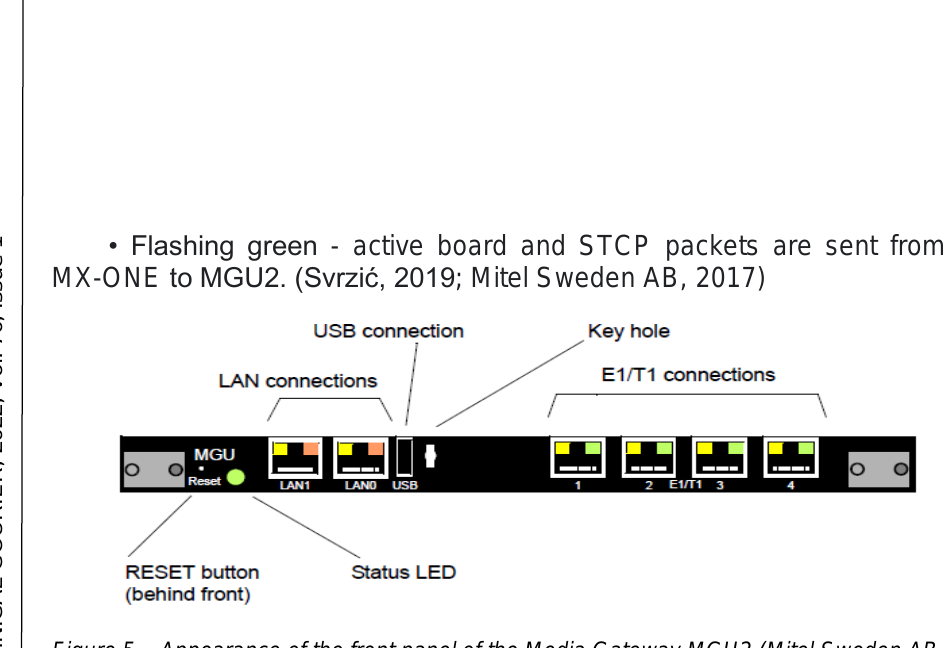
Figure 5 – Appearance of the front panel of the Media Gateway MGU2 (Mitel Sweden AB, 2017)